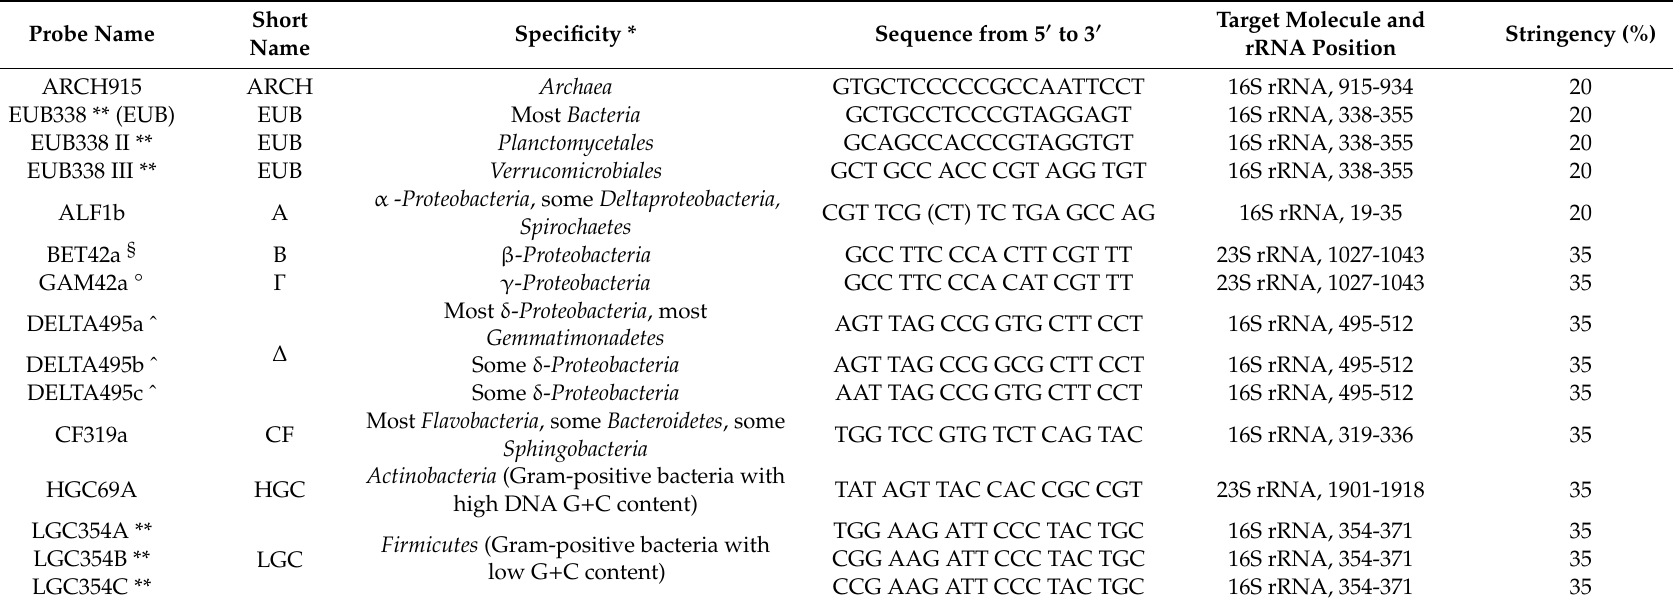
Table 2. Probe sequences, target sites for each probe, and % formamide used